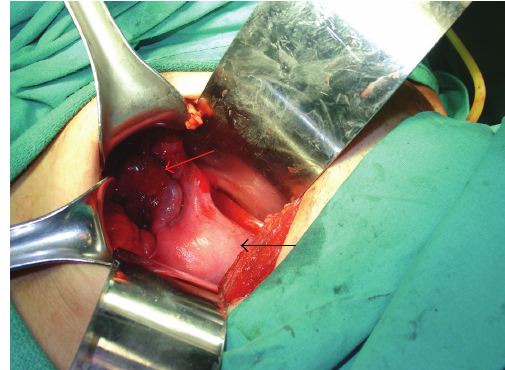
Figure 3: Enlarged left uterine horn (black arrow) with hematos- alpinx (red